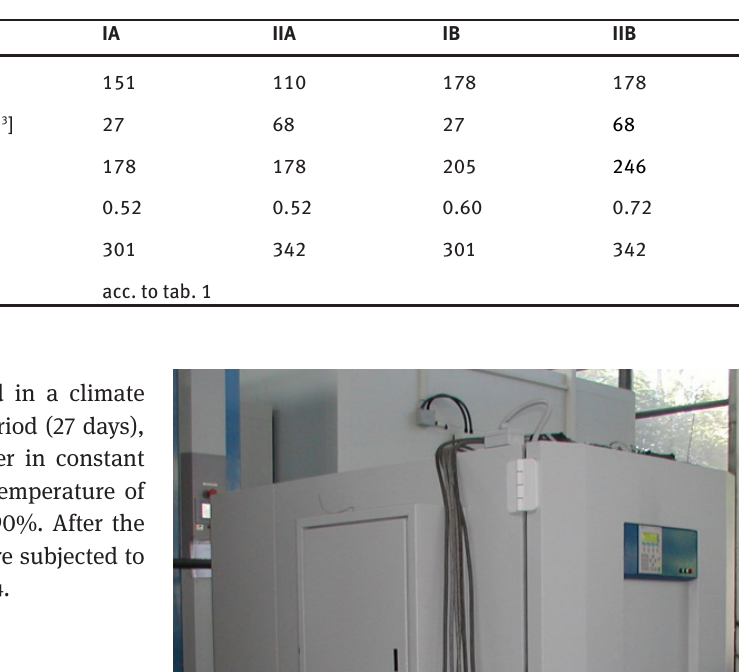
Table 3: Concrete mix designs.